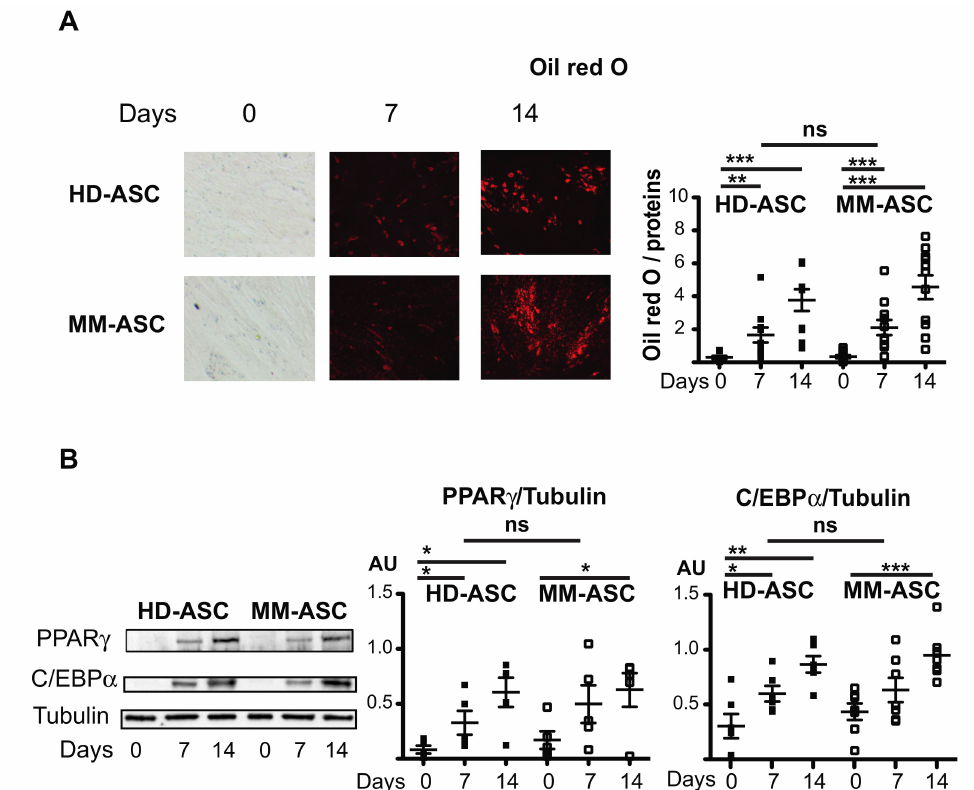
Figure 2. Adipocyte di ff erentiation is functional in MM patients. HD- and MM-ASC were di ff erentiated into adipocytes for 7 or 14 days. ( A ) The cells were stained with Oil-red-O to visualize lipid droplets after 7 or 14 days of di ff erentiation and representative micrographs and scans are shown (left). Staining was quantified at 520 nm and normalized to the protein content (right). ( B ) Whole cell lysates were extracted on day 0, 7, or 14 of di ff erentiation and analyzed by immunoblotting. Representative immunoblots of PPAR γ , C / EBP α , and tubulin (loading control) are shown in the left panel and Western blot quantifications in the two right panels. AU: arbitrary units. * p < 0.05, ** p < 0.01, *** p < 0.001, vs. day 0. NS, not significant. HD-ASC vs.